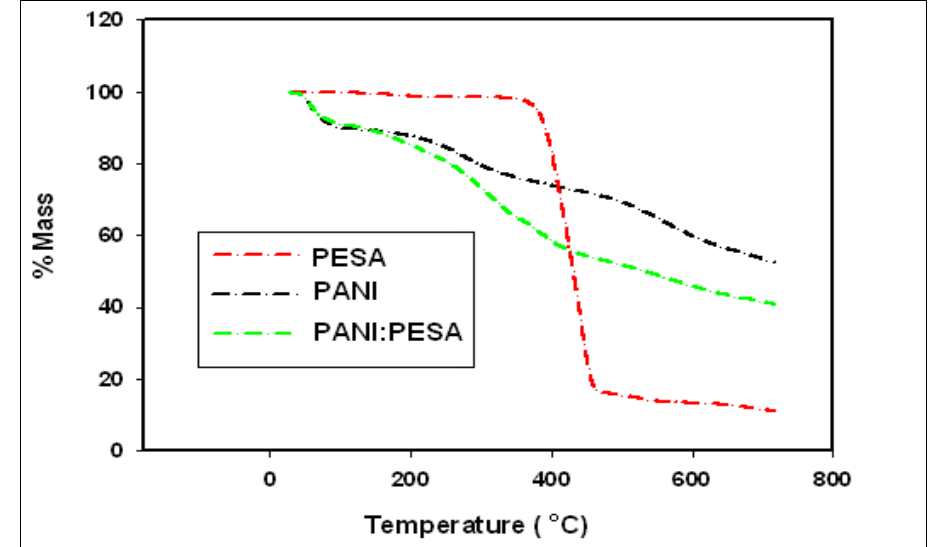
Figure 3. TGA plots of PESA, PANI and PANI:PESA.